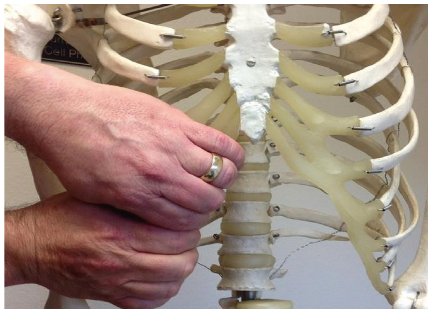
Figure 1: Hooking